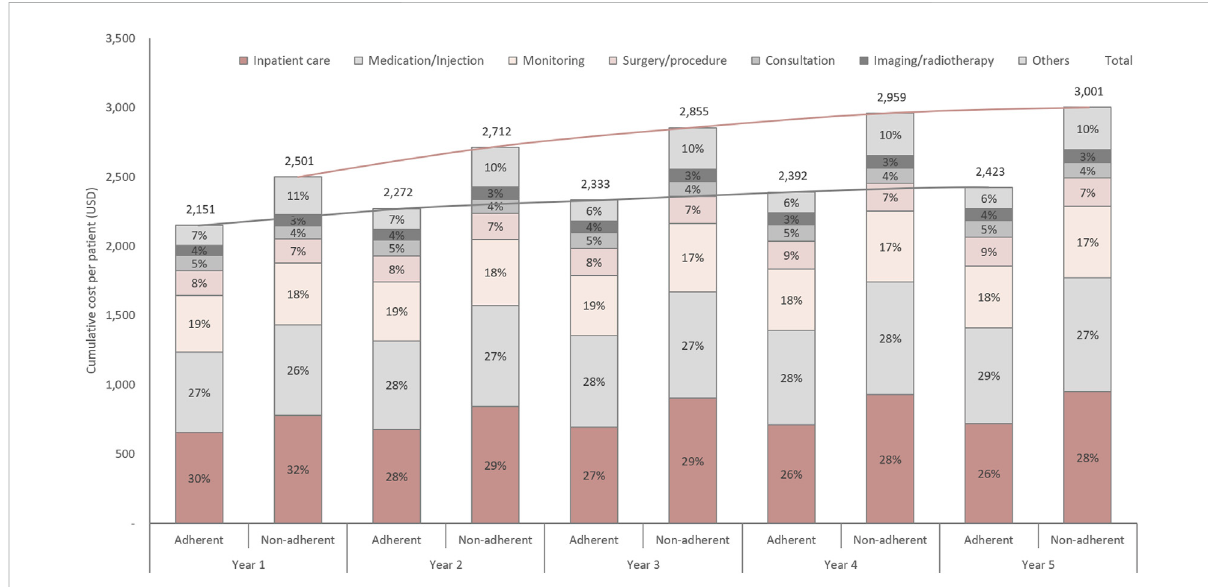
FIGURE 1 Initial treatment outcomes and retreatment rate in adherent and non-adherent groups. The height of the bars represents the proportion of patients. The initial number of adherent and non-adherent cells was 100%. MDR-TB, multidrug-resistant